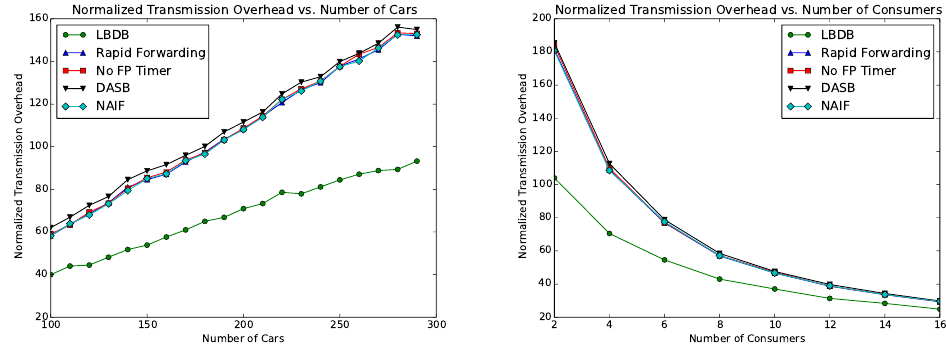
Figure 10. Normalized Transmission Overhead (interest and